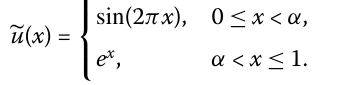
x = log h . For the interface problem, the constant C depends on the relative location of the interface and the mesh. Thus, we compute the slope of least squares fitting which can be regarded as the average convergence